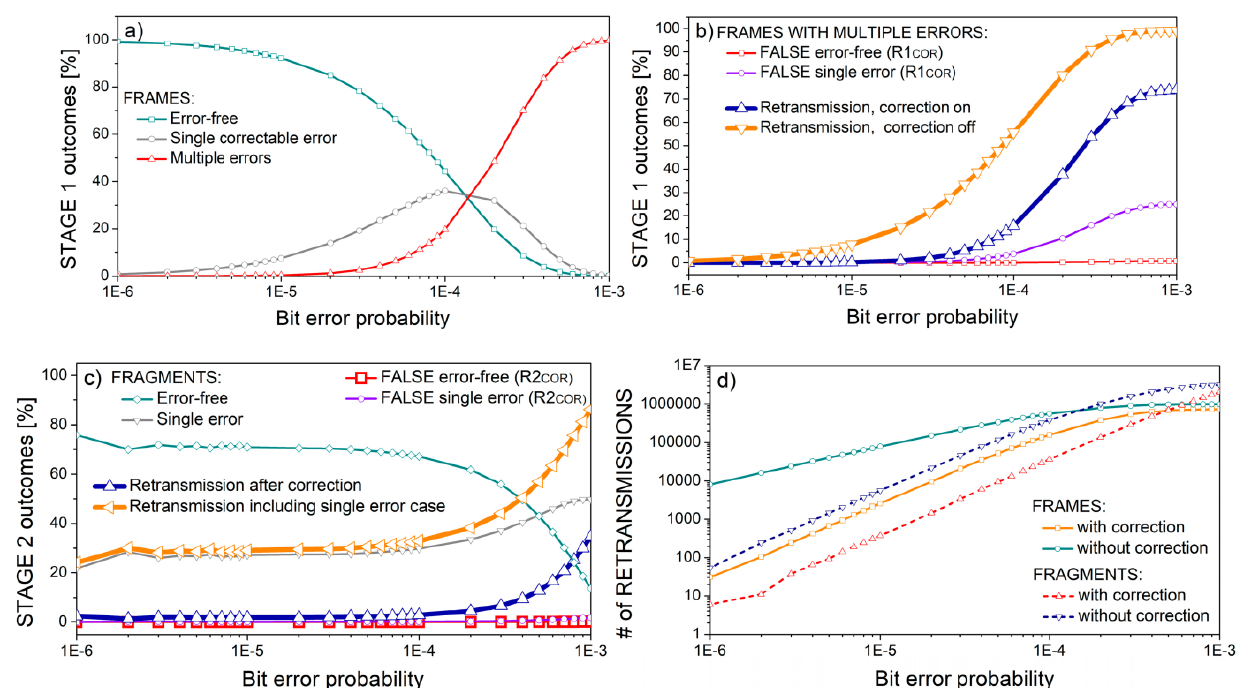
Figure 7. Outcomes of different stages as a function of bit error probability p , for symbol length m = 8 and frame partitioned into eight fragments of length equal to 2 m − 1 − 1 = 127 symbols. ( a ) Frame error events distribution; ( b ) multiple errors event distribution per frame; ( c ) multiple error events distribution per fragment; ( d ) number of retransmitted frames and fragments with error correction turned on and off.